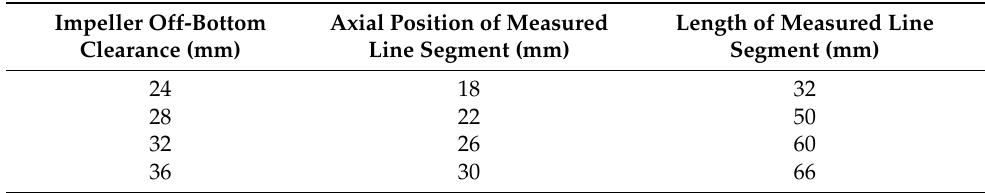
Table 1. Correspondence between the axial position and the length of the measuring line segment and the impeller off-bottom clearance. Impeller